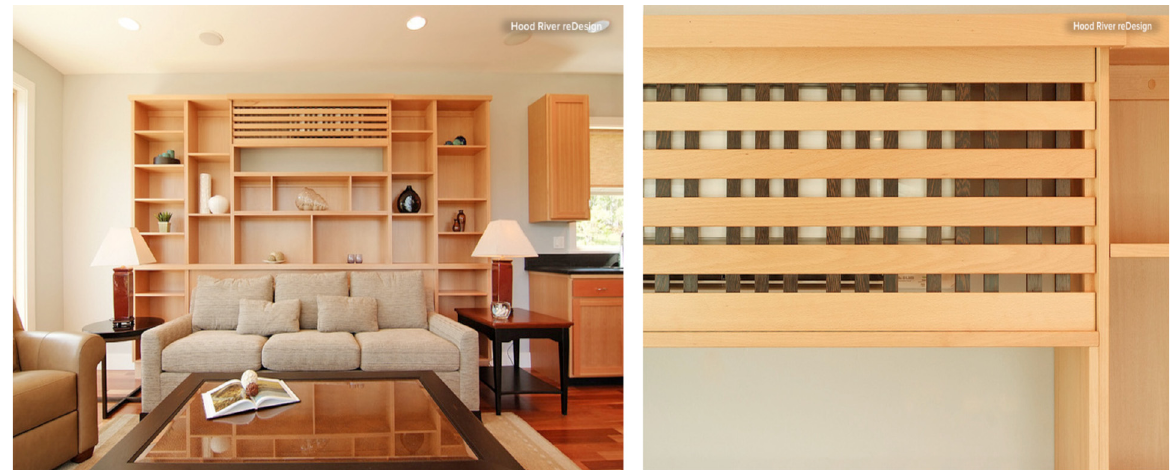
Fig. 2. Air conditioner hidden in the furniture.